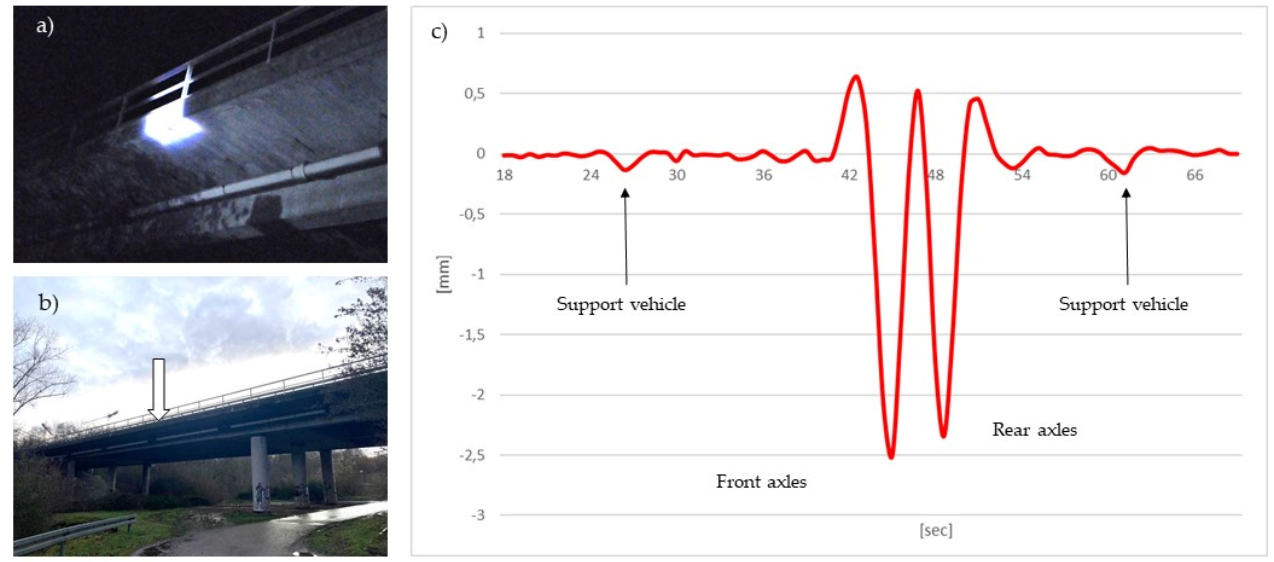
Figure 2. Illumination ( a ) and position ( b ) of the measured target in the middle of the bridge. ( c ) Representation of the vertical displacement of a target point during a heavy transport on a concrete bridge in Mainz (Germany) using prototype MoDiTa at night [69].